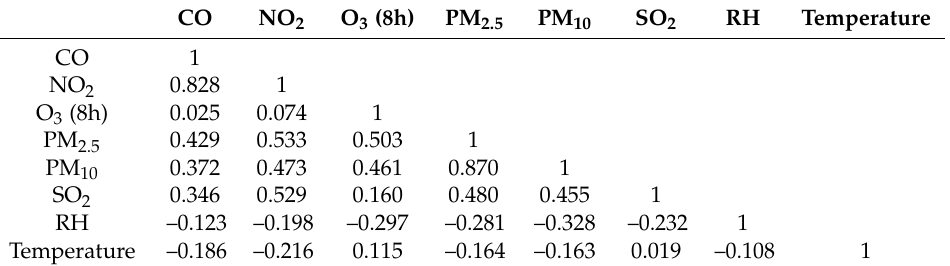
Table 2. Spearman correlation among daily air pollutants and meteorological